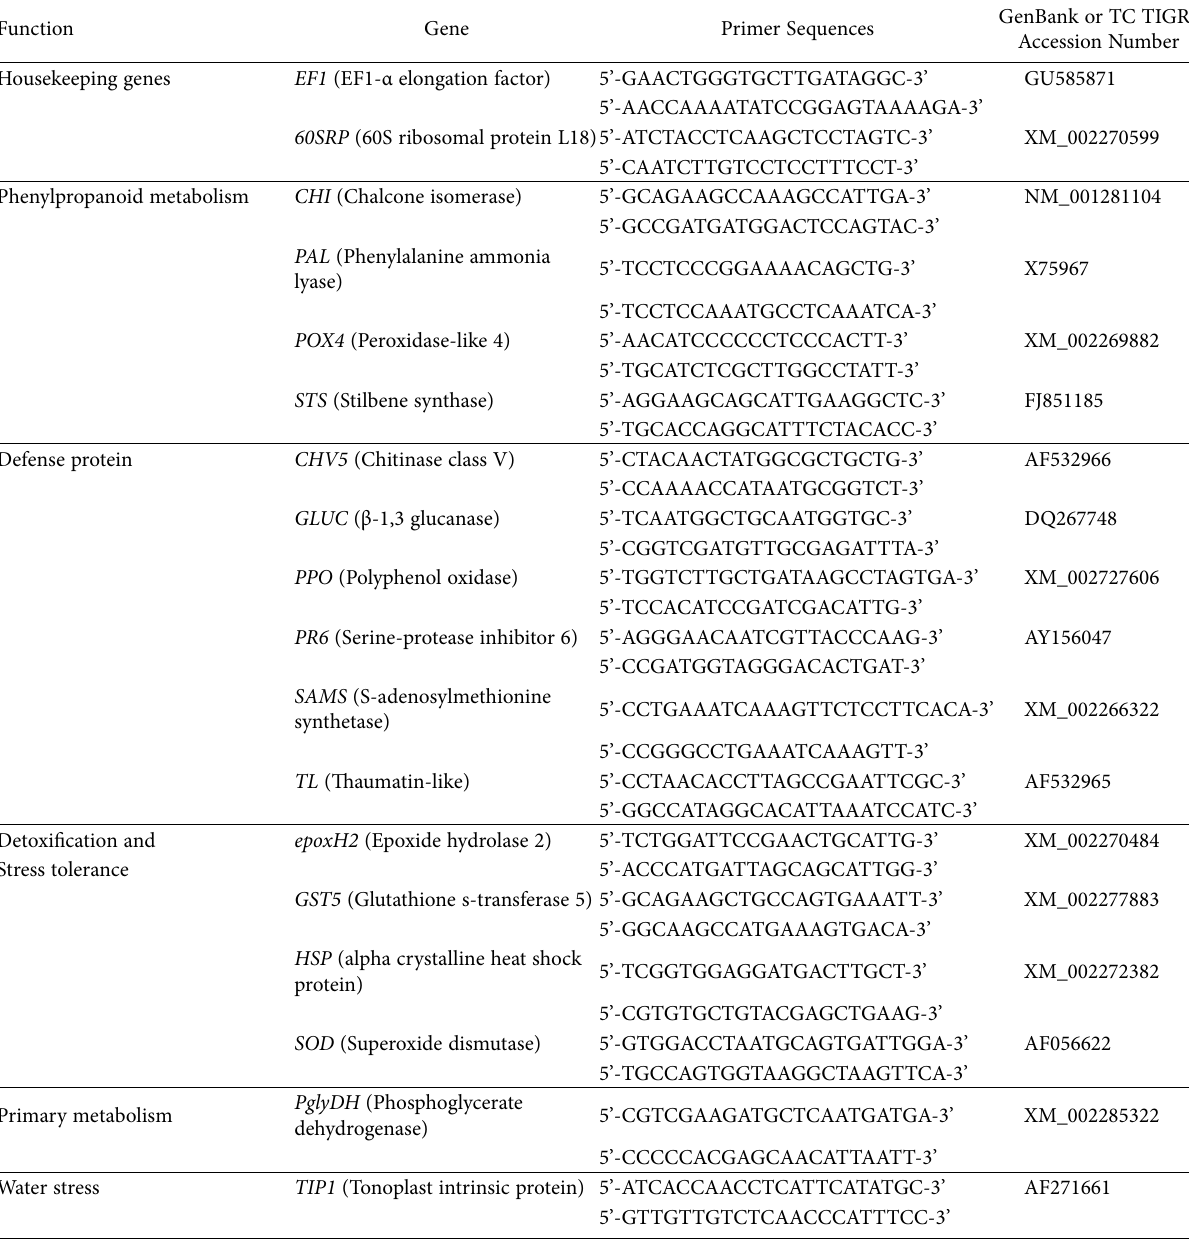
Table 1. Primers of genes analyzed by real-time reverse-transcription polymerase chain